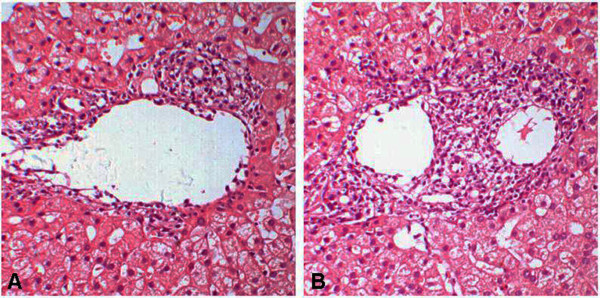
The histopathological features of acute cellular rejection. Typical histopathological changes, including portal inflammation, bile duct inflammation/damage and venous endotheliatis, so called “triads,” appeared in mild (A, RAI = 4) and moderate (B, RAI = 7) acute cellular rejection (H&E, ×200).